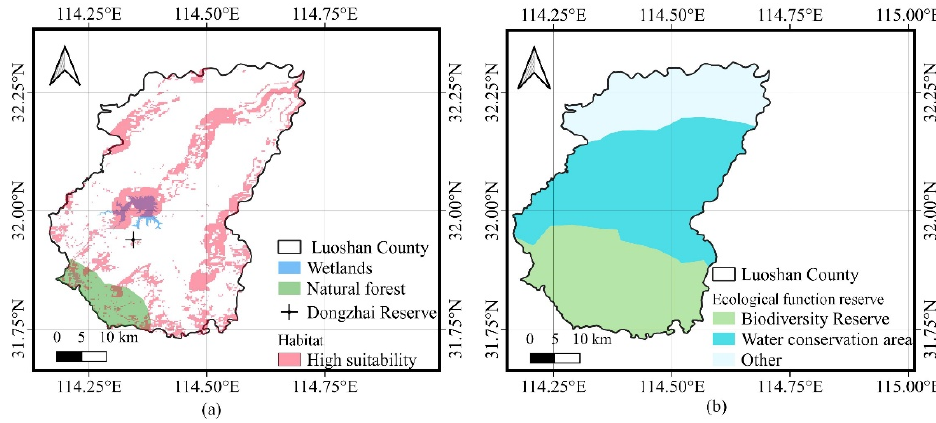
Figure 9. ( a ) High ‐ suitability habitat; ( b ) Ecological function